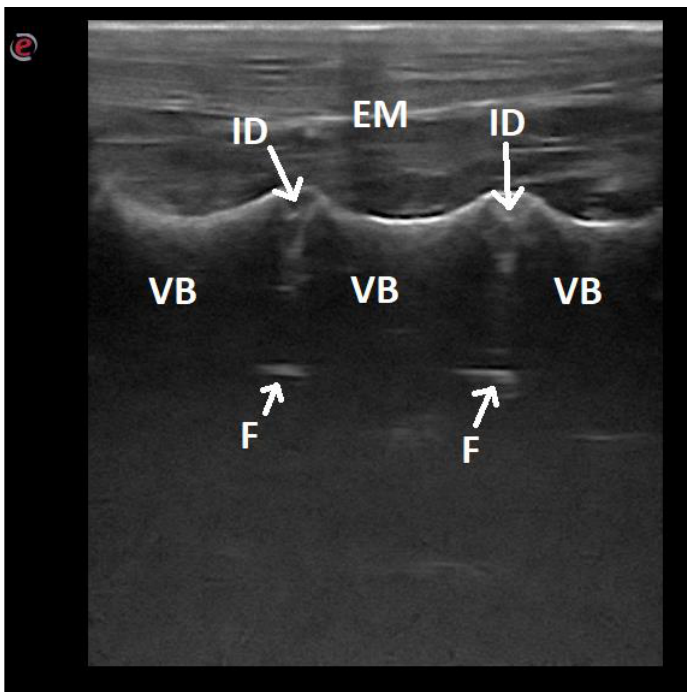
Figure 6. Ultrasonographic image of the lumbar spine of a dog in the longitudinal paramedian plane on the ventral side: EM—epaxial muscles; ID—intervertebral disc; VB—vertebra body; F—floor of the vertebral canal.